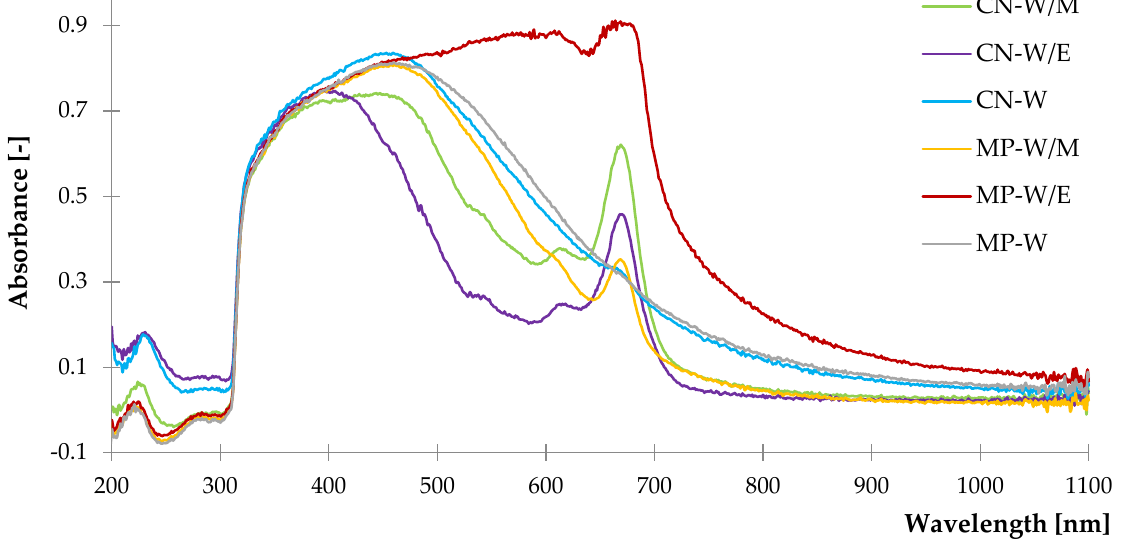
Figure 4. The UV-VIS spectra of freeze-dried extracts.